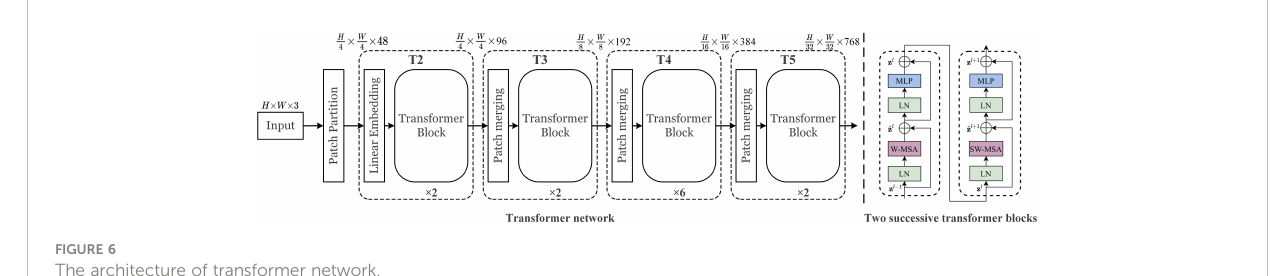
FIGURE 6 The architecture of transformer